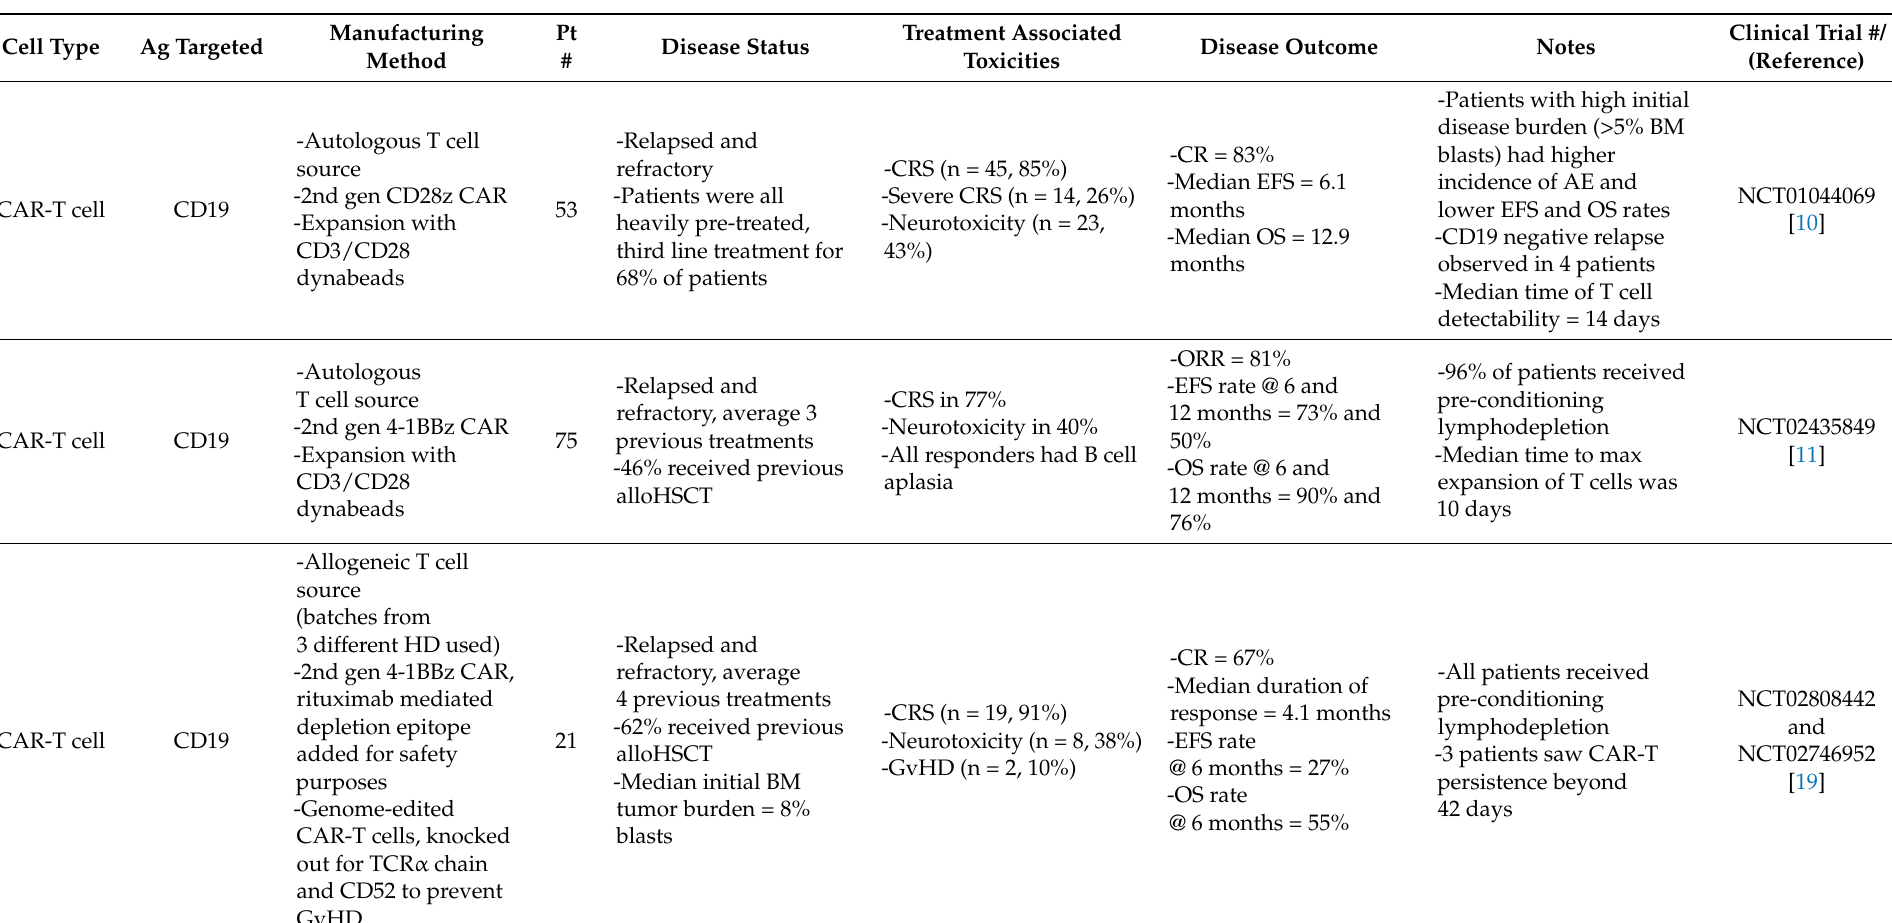
Table 1. Adoptive cellular therapies used to treat B-ALL in clinical